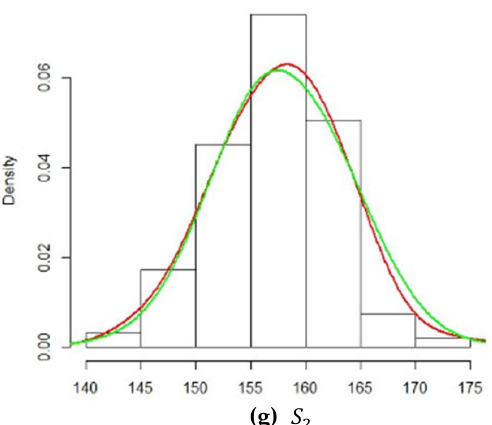
Figure 3. Frequency histograms of all the confidential and non-confidential data.